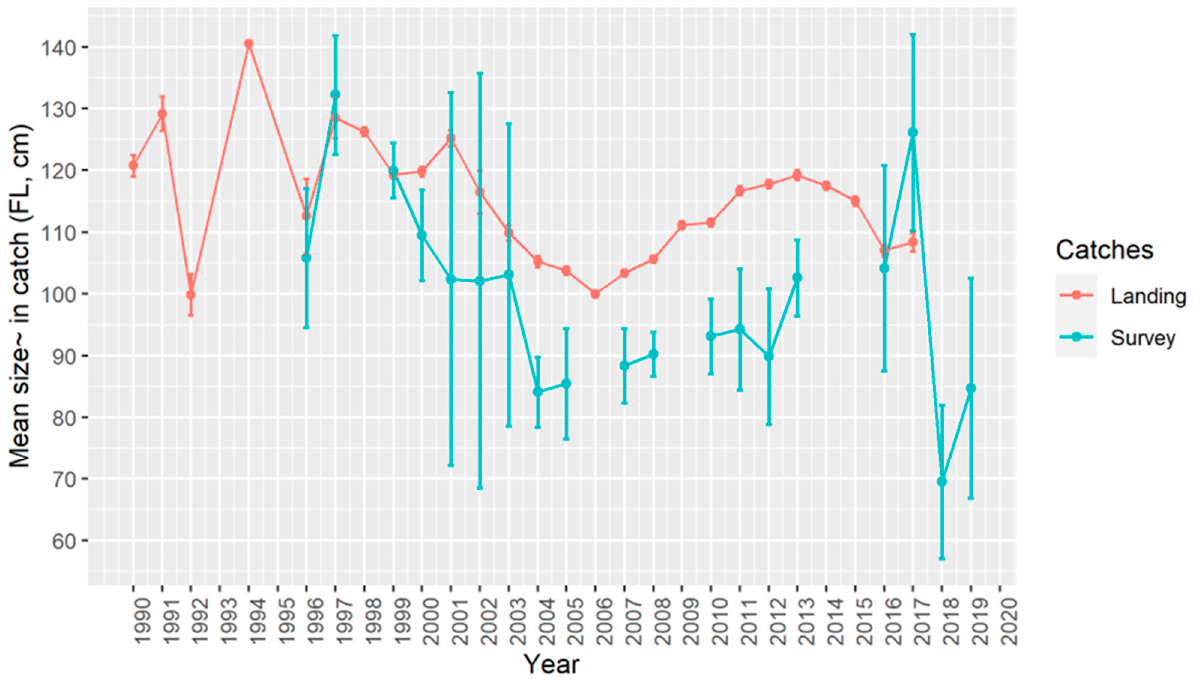
Figure 5. Annual mean fork length (FL) of Lepidopus caudatus from the Azores derived from offi-